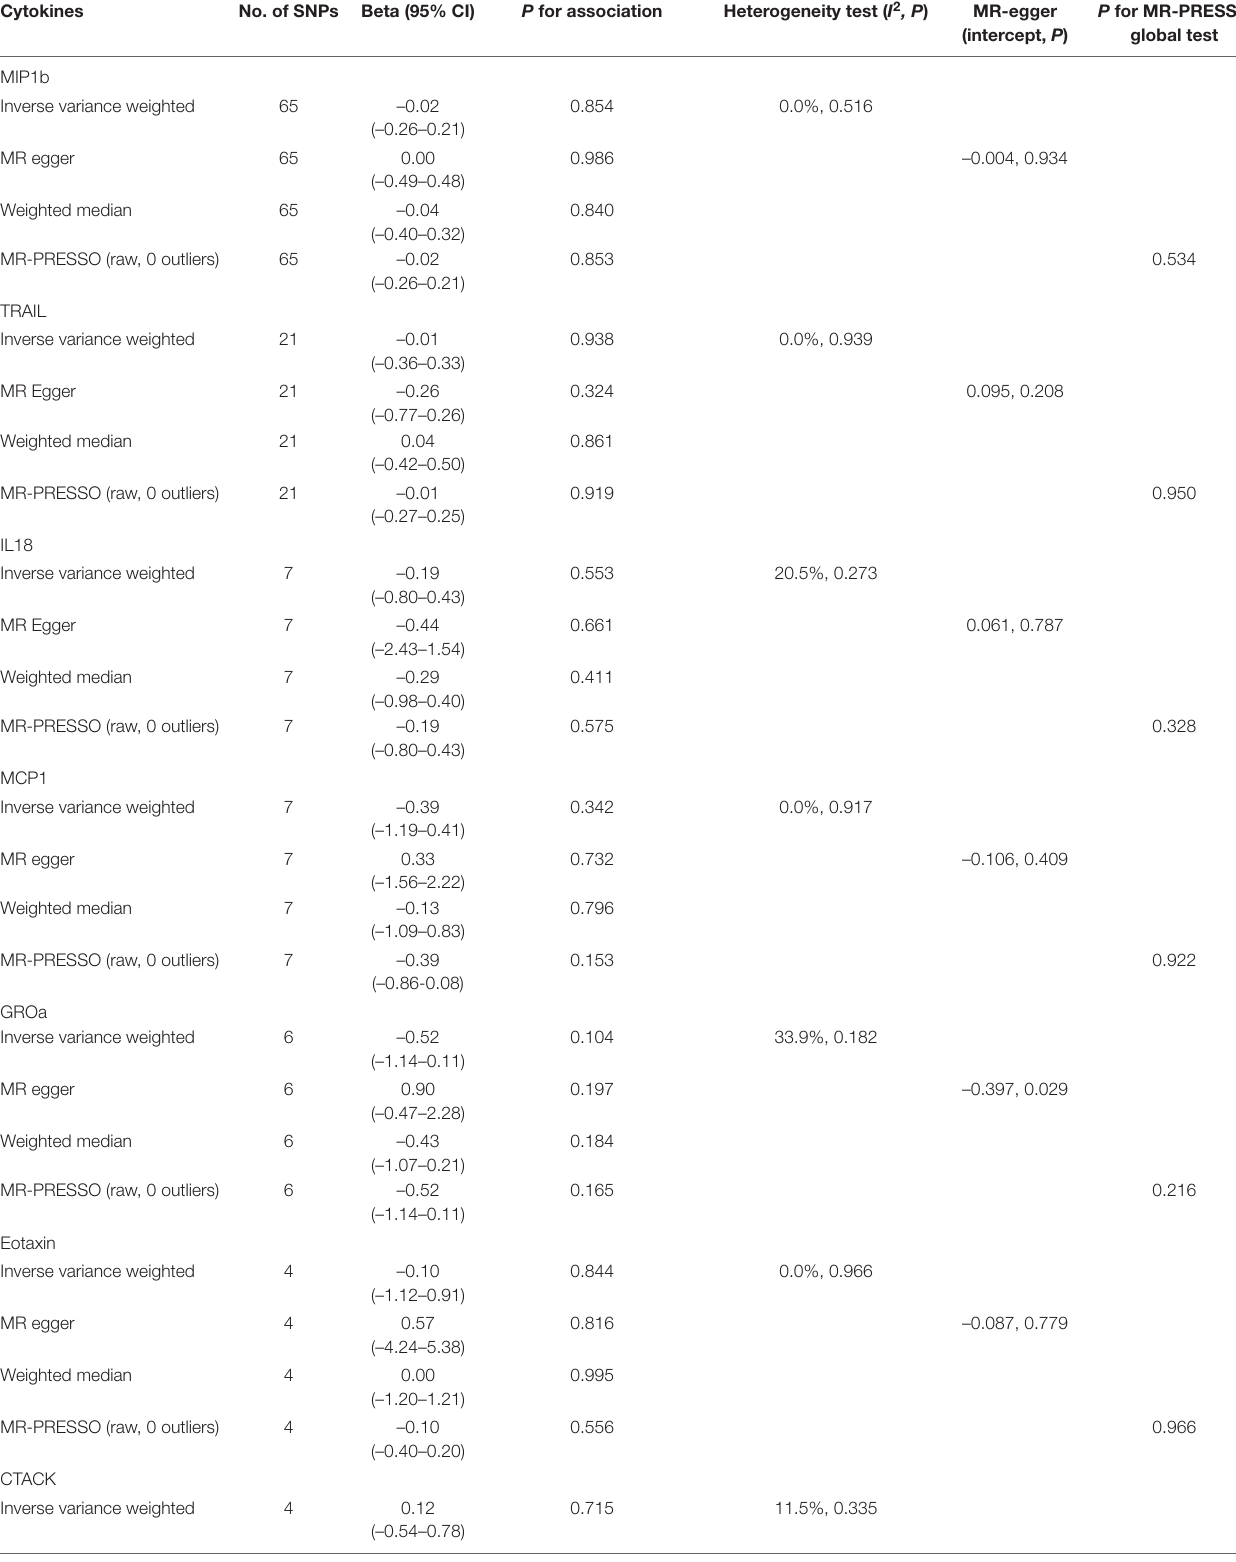
TABLE 2 | MR analysis of genetically predicted levels of circulating inflammatory cytokines and age at onset of Parkinson’s disease.